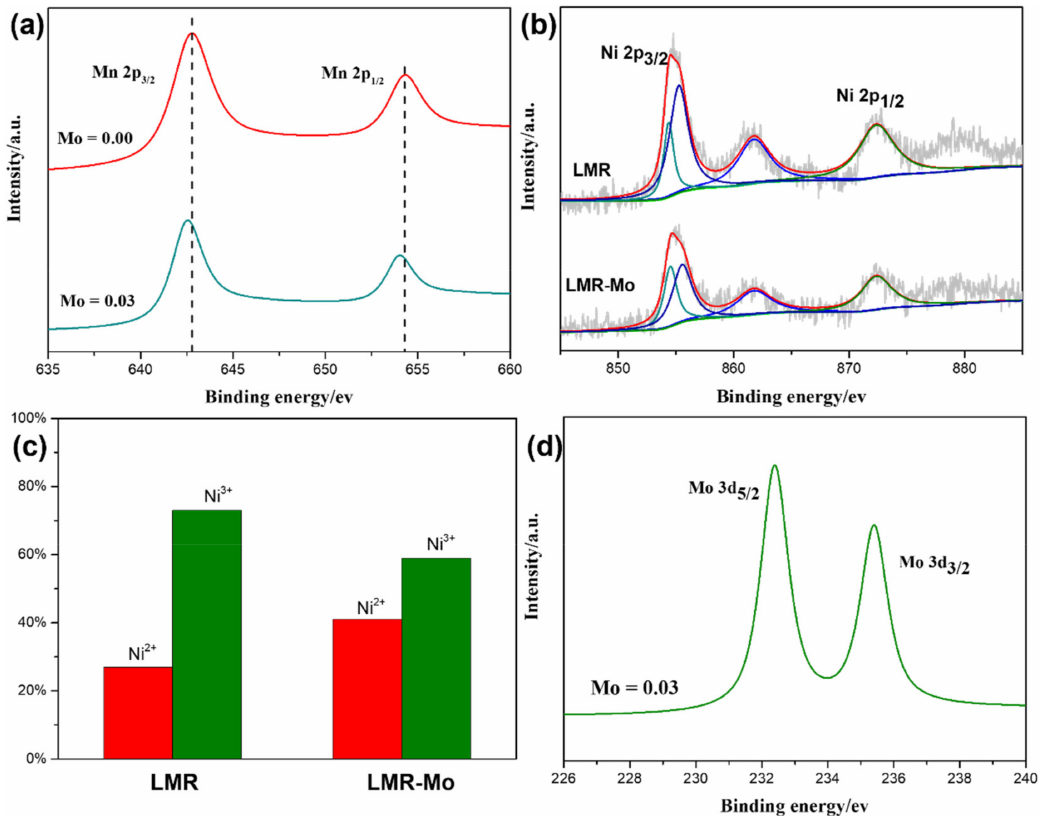
Figure 3. ( a ) XPS results for Mn 2p. ( b ) Experimental and fitted Ni 2p. ( c ) Percentages of Ni 2+ and Ni 3+ derived from the fitted spectra in b. ( d ) XPS results for Mo 3d at various depths in